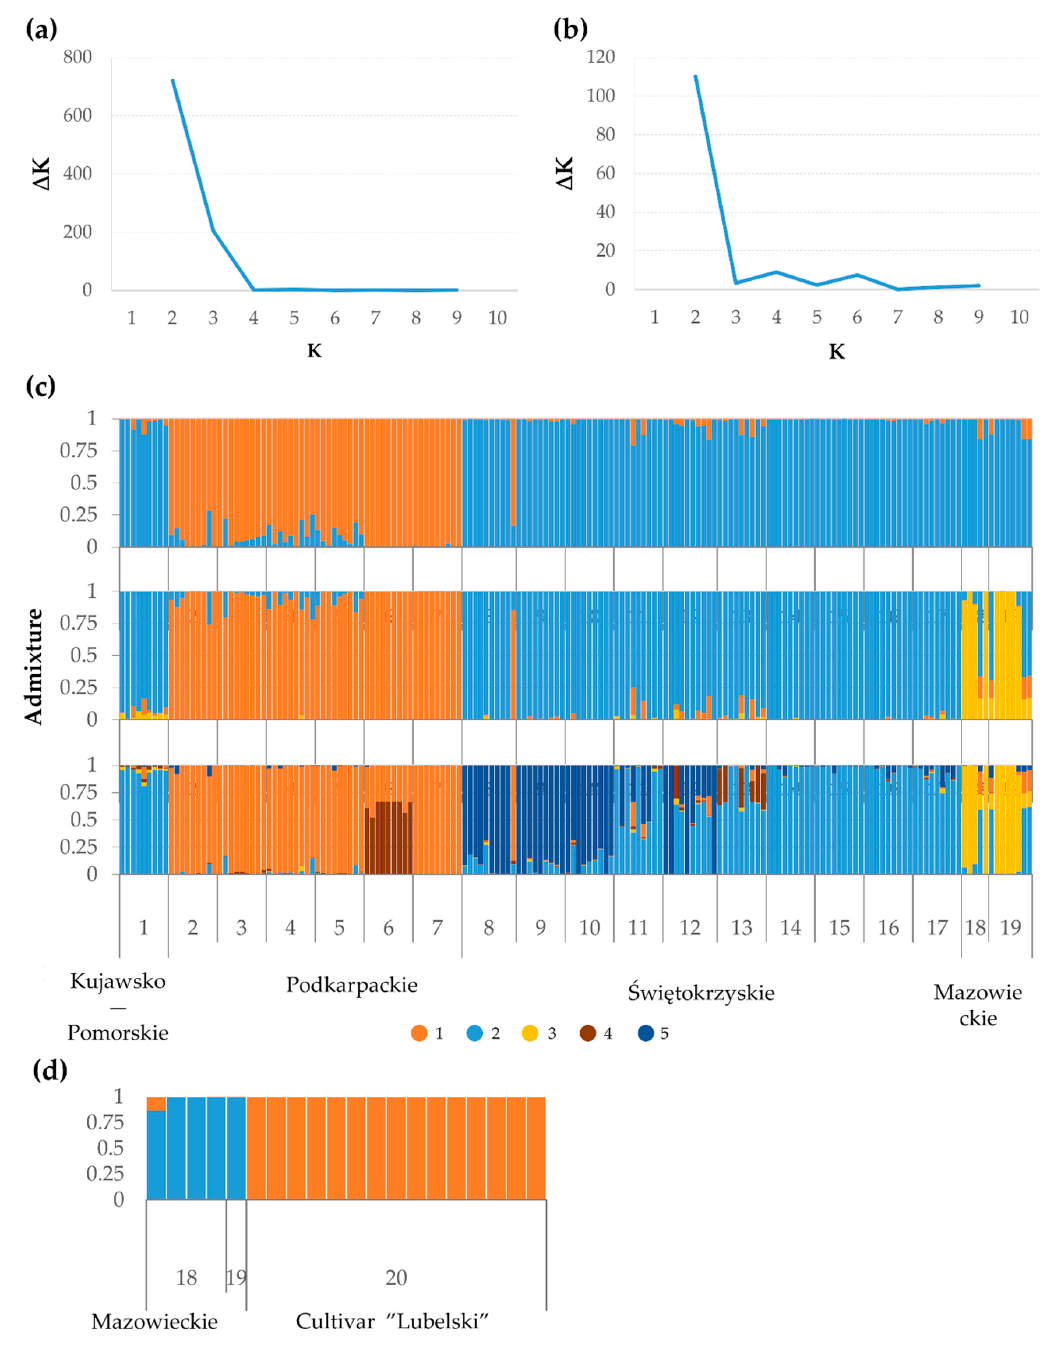
Figure 6. The population structure analysis based on SNP markers. ( a ) The results of the most probable value of K ( ∆ K) measures [22] for diploids; ( b ) the results of the ∆ K measure for tetraploids; ( c ) the results of 100,000 iterations of Bayesian clustering algorithms using an admixture and correlated allele frequencies model by STRUCTURE software [24] with K = 2, K = 3 and K = 5, where K is the number of groups assumed for diploids, and ( d ) the results of 100,000 iterations of Bayesian clustering algorithms using an admixture and correlated allele frequencies model by STRUCTURE software with K = 2, where K is the number of groups assumed for tetraploids. Each vertical bar represents a single plant. The length of the colored segment shows the estimated proportion of membership of that sample to each group. Accession numbering is in accordance with Table 1.